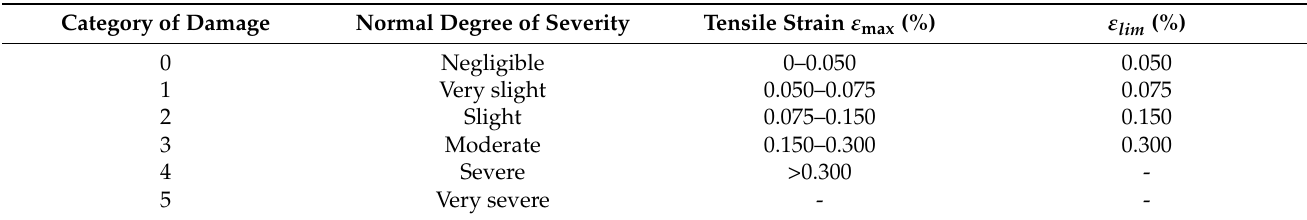
Table 1. Classification of damage to buildings (Burland and Wroth